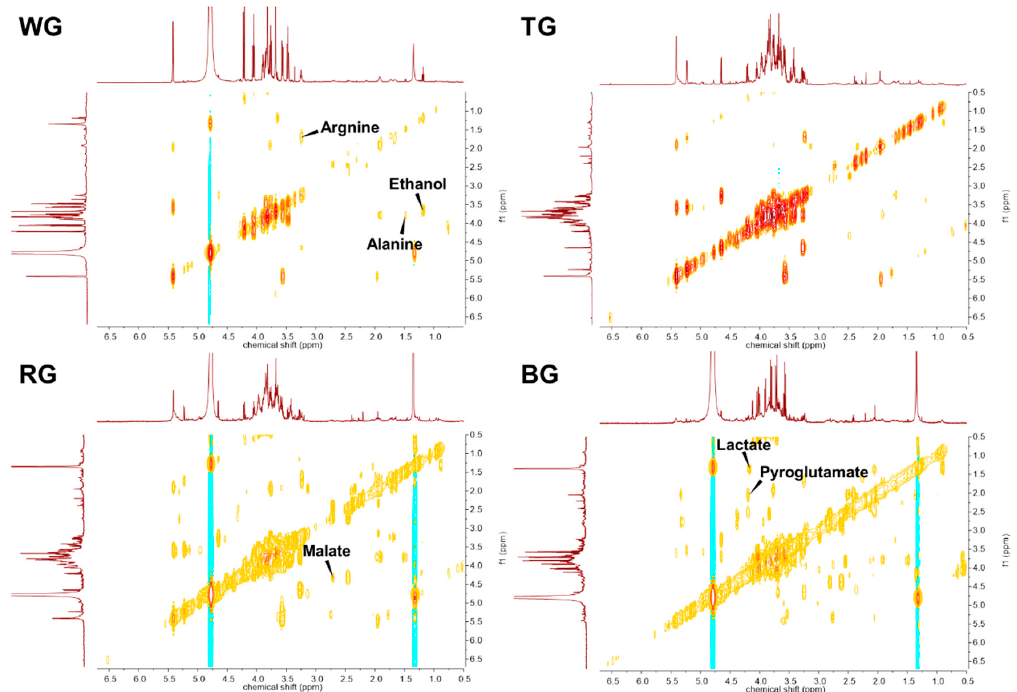
Figure 2. Representative 2D-COSY HR-MAS NMR spectra of four processed ginseng